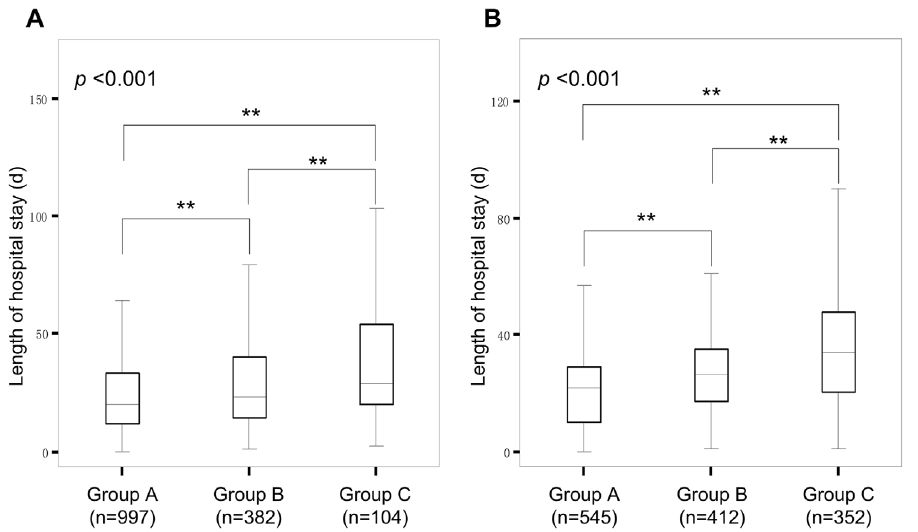
Figure 1. The relationship between the frequency of critical values and the length of hospital stay. Note: (A) critical values of serum potassium. (B) critical values of platelet count. The patients were divided into 3 groups based on the frequency of the critical values: group A (1 time), group B (2–3 times), group C ( $ 4 times). Statistics: box plots showing the median, quartiles, and range. Kruskal-Wallis nonparametric test, p -values shown. Man-Whitney U tests (** p , 0.0033).